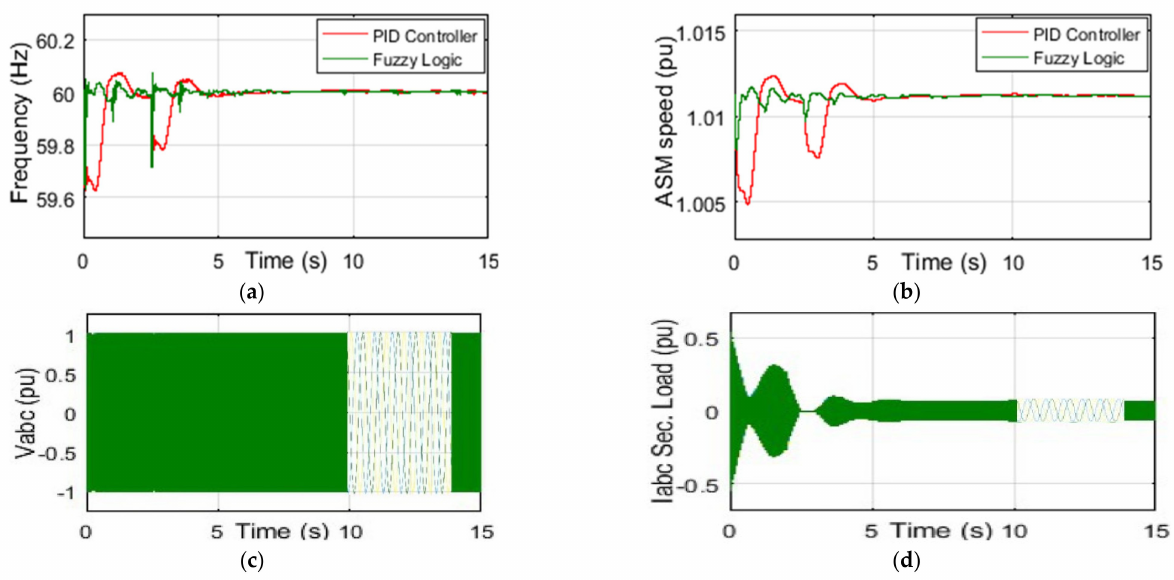
Figure 12. ( a ) Network frequency conditions. ( b ) Speed generated by ASM generator. ( c ) Voltage at load bus. ( d ) The current at SL, when the BESS is